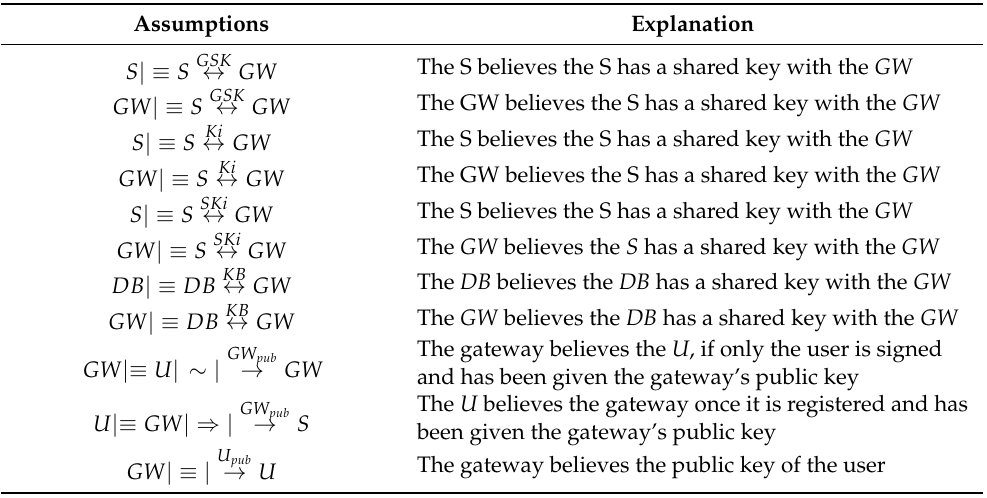
Table 9. Assumptions used in the lightweight authentication MAC protocol for the CR-WSNs.